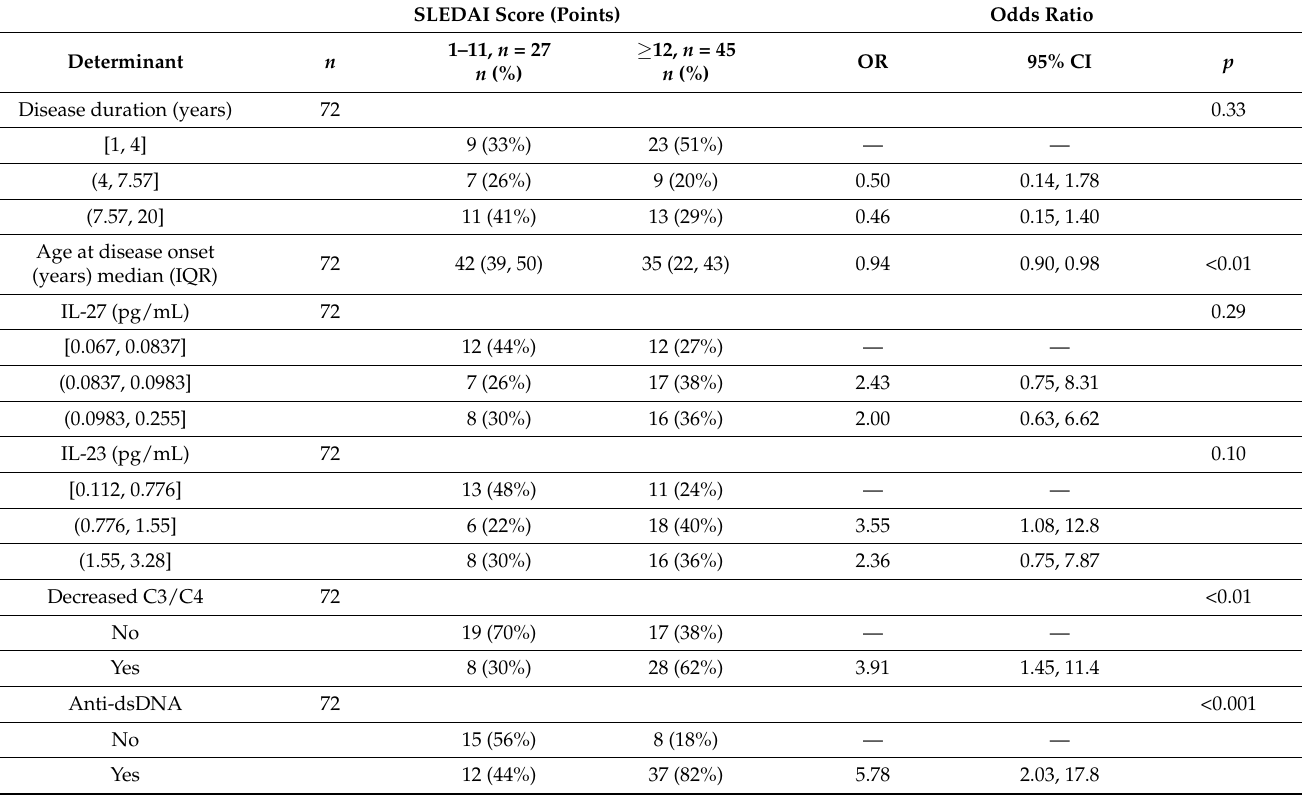
Table 3. Determinants of disease activity in the whole group of